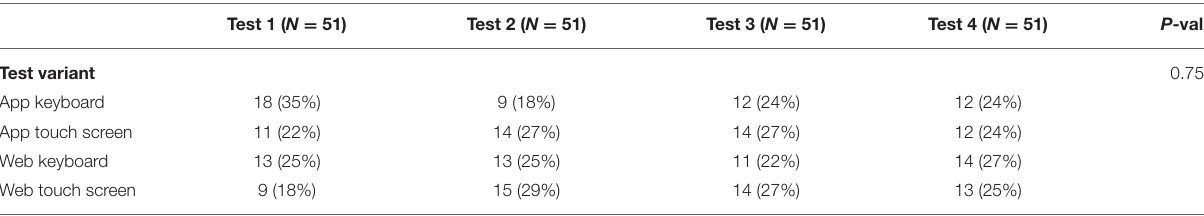
TABLE 6 | Test variants vs. order in which they were conducted (random assignments per participant).